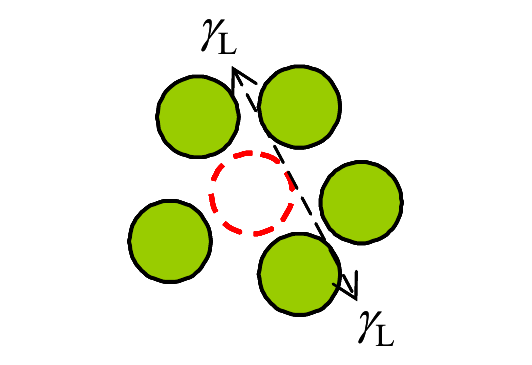
Figure 5. Two-dimensional diagram for a snapshot of the proposed liquid nucleus, namely, a small number of atoms surrounding a vacancy with the forces exerted by the atoms ( i.e ., the surface tension γ L indicated by the dashed arrows) in equilibrium with the energy of a vacancy (dashed empty